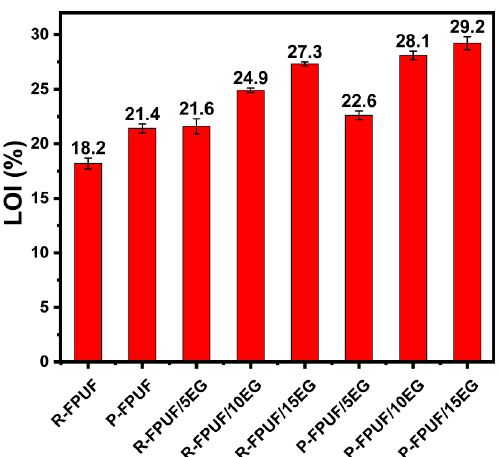
Figure 3. LOI bar graph of R-FPUF and flame-retardant FPUFs.